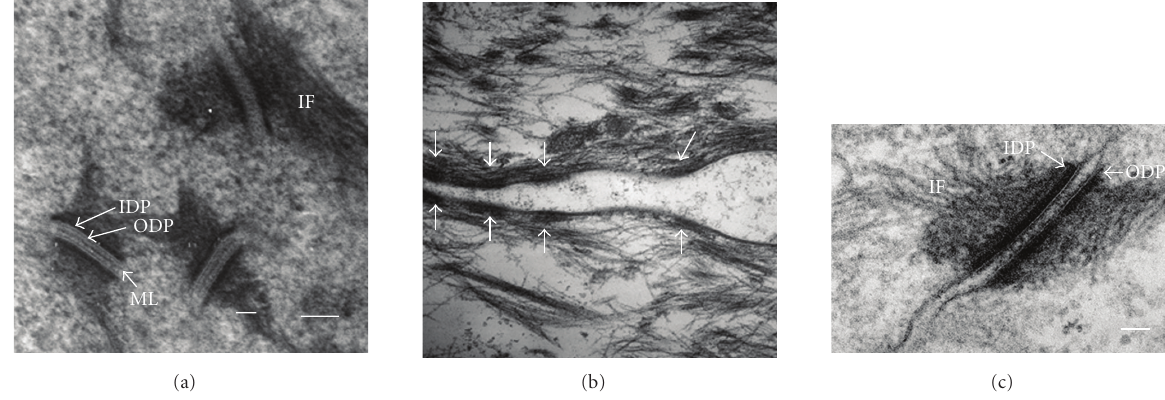
Figure 4: Transmission electron micrographs of desmosomes in mouse epidermis. Normal (a) and wound-edge (b) mouse epidermis after exposure to LCM-EGTA for 6 hours (a) and 1 hour (b). Note that the desmosomes in (a) are intact and two that are sectioned precisely transversely exhibit entirely unaltered structure, whereas in (b) the desmosomal halves (arrows) have lost adhesion and separated (compare with Figure 3(d)). Thus the desmosomes in (a) are calcium independent and those in (b) are calcium dependent. (c) An example of transversely sectioned desmosomes from untreated wound-edge epidermis showing absence of midline but plaque structure appears unchanged at this resolution. ML, midline; ODP, outer dense plaque; IDP, inner dense plaque; IF, intermediate filaments. Bar: 0.1 m. Reproduced from the study by Garrod et al. in